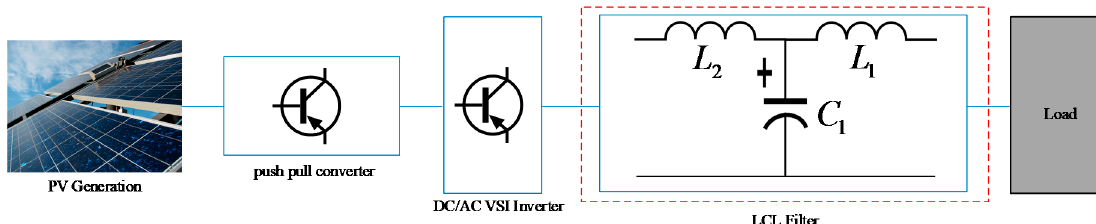
Figure 8. Application of LCL filter in PV system.